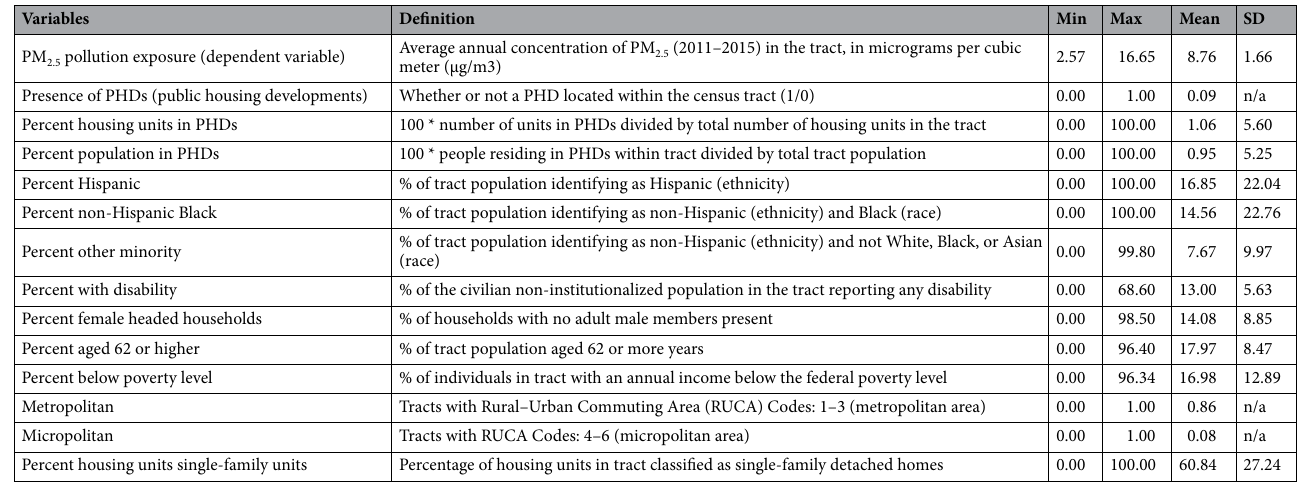
Table 1. Census tract level analysis: variable definitions and summary statistics. N = 61,117 tracts (with at least 500 people and 200 housing units) in counties of continental US with public